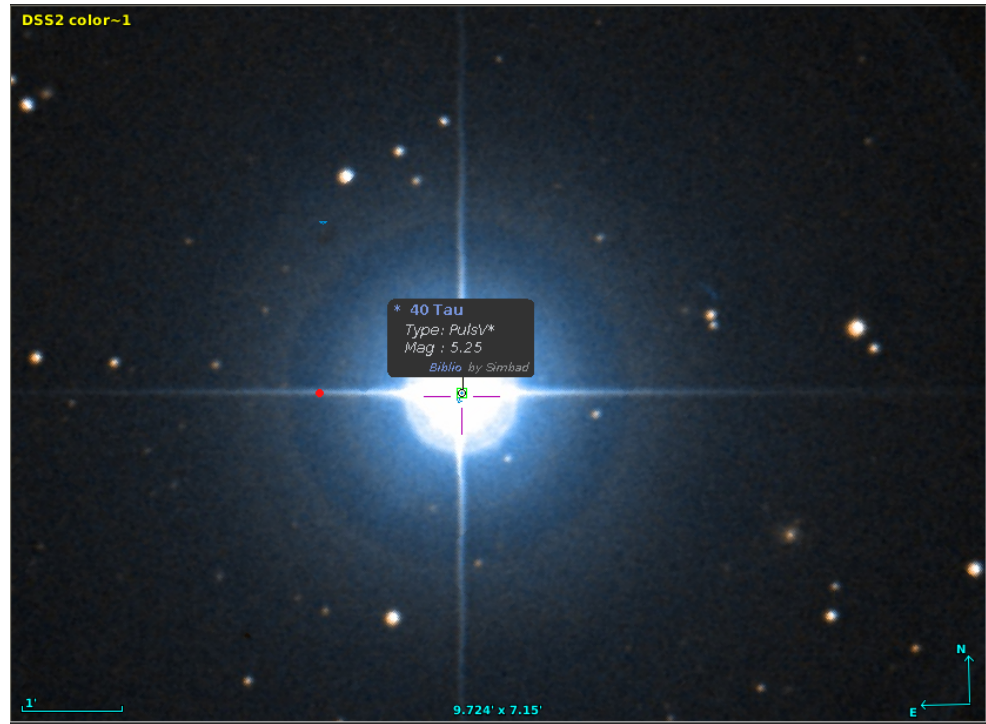
Figure 2. Spurious entry in the sample of 150,000 candidates lying on the spikes of a bright star (red dot). These type of sources are removed during the preprocessing